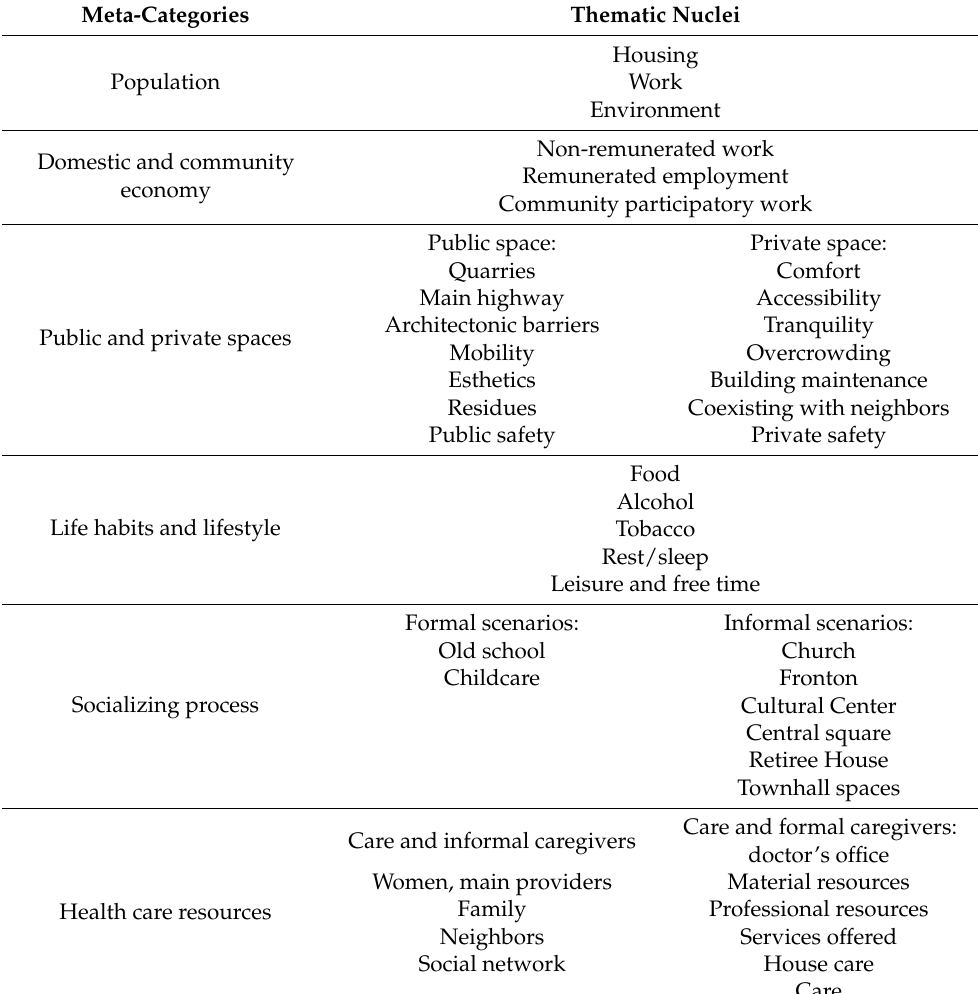
Table 3. Meta-categories and thematic